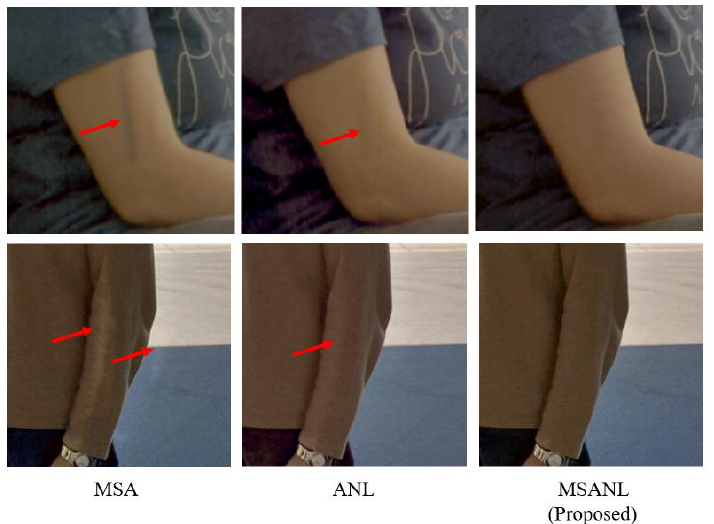
Figure 9. Qualitative comparison of the performance of the proposed method (MSANLnet) and its baseline